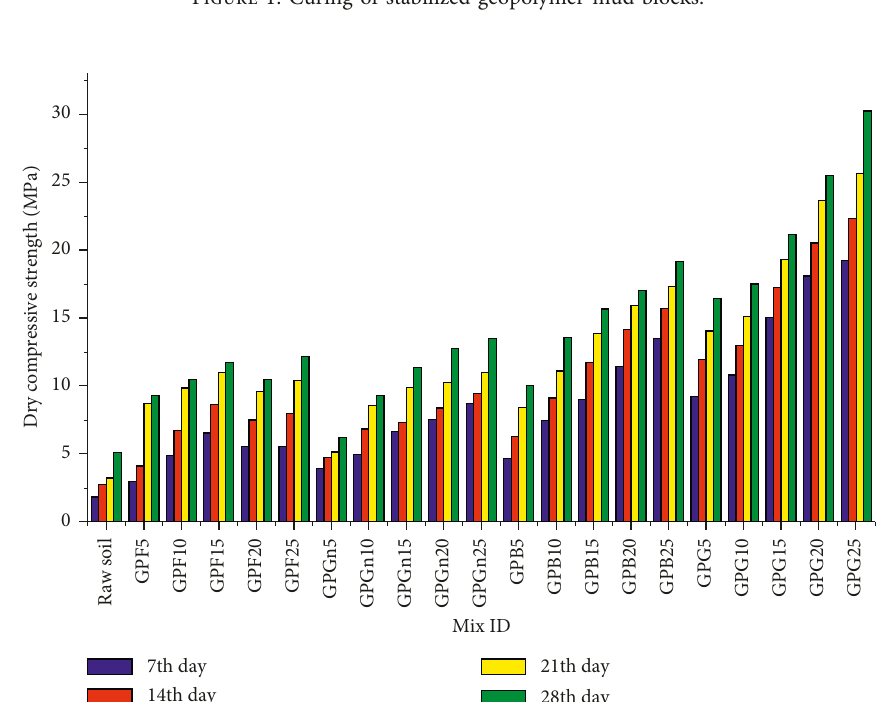
Figure 2: Dry compressive strength for stabilized geopolymer mud